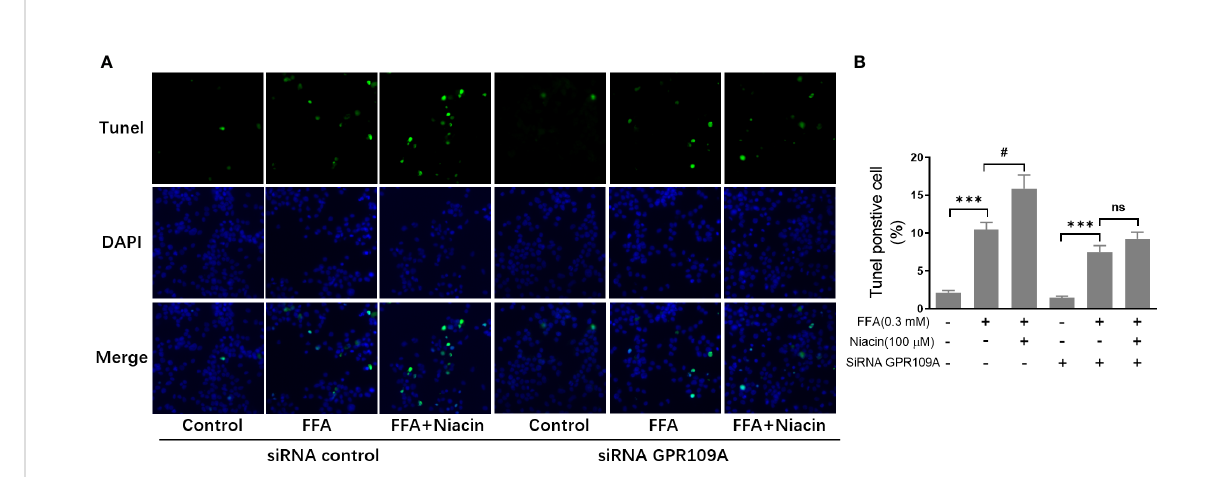
FIGURE 6 Inhibition of GRR109A mRNA expression by siRNA attenuates niacin induced apoptosis in the presence of FFA. INS ‐ 1 cells were transfected with control or GPR109A siRNA for 12 hours, then cells were treated with FFA or FFA plus niacin for 48 hours. (A) Representative images of immuno fl uorescence. Green, TUNEL positive cells; blue, 4 ’ ,6-diamidino-2-phenylindole (DAPI). (B) TUNEL positive cells were quanti fi ed and expressed as percentage of total cells. The results are displayed as the means ± SD. n = 5, ***P < 0.001 compared to respective control group; # P < 0.05 compared to the siRNA control plus FFA group. NS means not signi fi cant